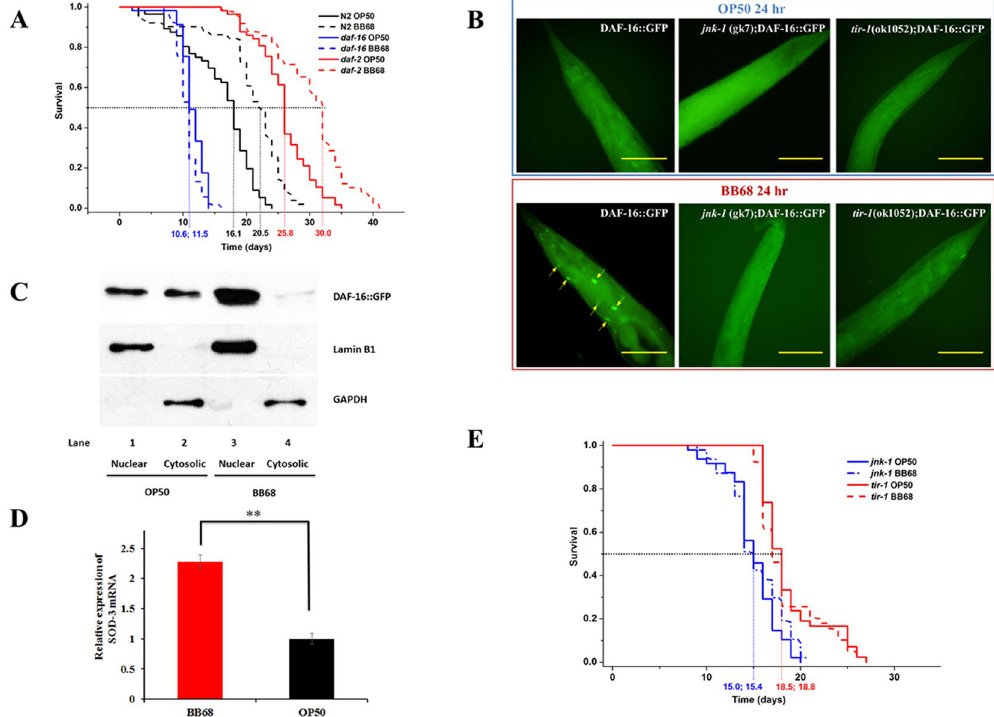
Figure 1. Bifidobacterium longum BB68 extends the lifespan of C. elegans by regulating TIR-1 – JNK-1 – DAF- 16 signaling. ( A ) Feeding worms BB68 increased the lifespan of the N2 and daf-2 strains, but not the daf-16 strain. ( B ) Feeding DAF-16::GFP worms BB68 for 24 h activated DAF-16 (the arrows indicate increased nuclear accumulation of DAF-16), and lower levels of activated DAF-16 were detected in the presence of mutated jnk-1 or tir-1 . ( C ) Western blotting showed significant nuclear accumulation of DAF-16 protein in nematodes fed BB68 for 24 h. Lamin B1 was used as a nuclear reference, and GAPDH was used as a cytosolic reference. ( D ) An increase in SOD-3 gene expression level was observed in nematodes fed BB68 for 24 h. ** Indicates a significant difference (Student’s T-test, p < 0.01). The test was conducted in triplicate. ( E ) The presence of mutant jnk-1 and tir-1 completely eliminated the lifespan extension induced by BB68. Scale bar = 50 μ